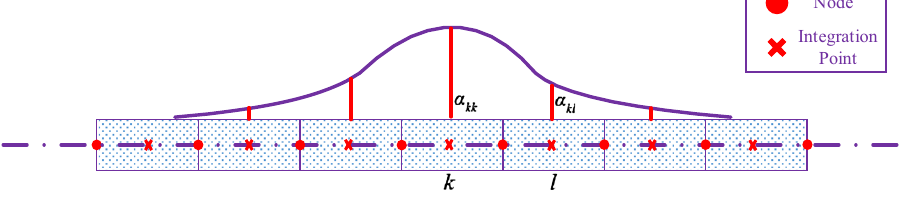
Fig. 11 Integration scheme and weighting function along the element.